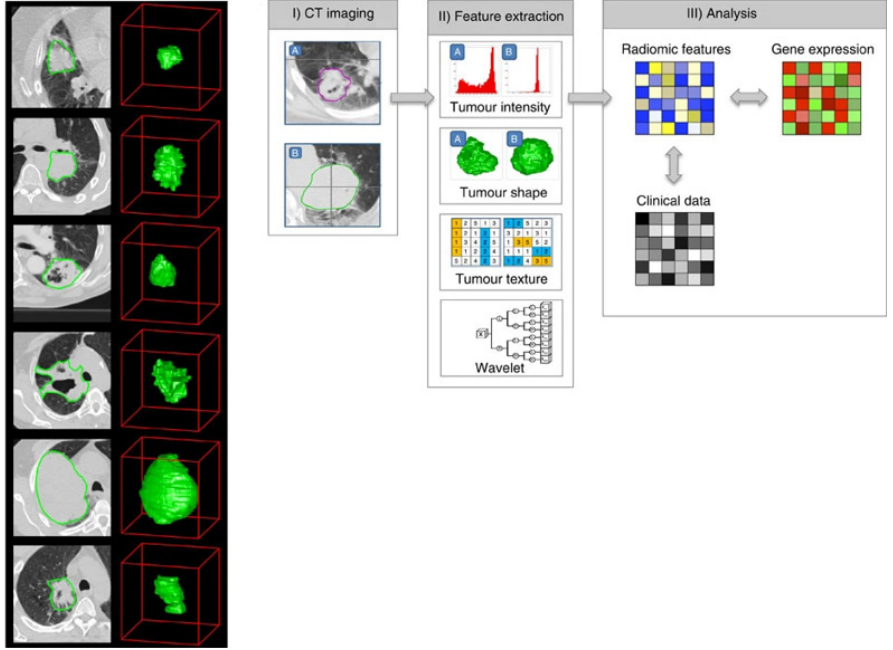
Figure 1. Typical workflow in a radiomics study, reproduced with permission from [104].